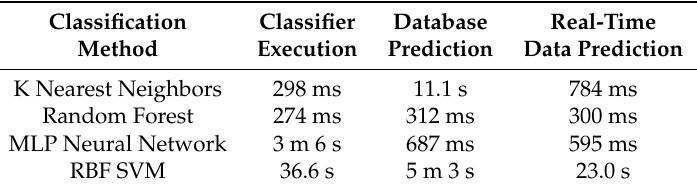
Table 2. Computational performances of classification